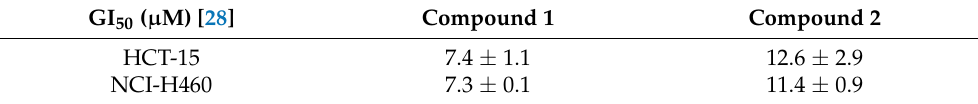
Table 1. Growth inhibitory concentrations (GI 50 ) of compounds 1 and 2 in human tumor cell